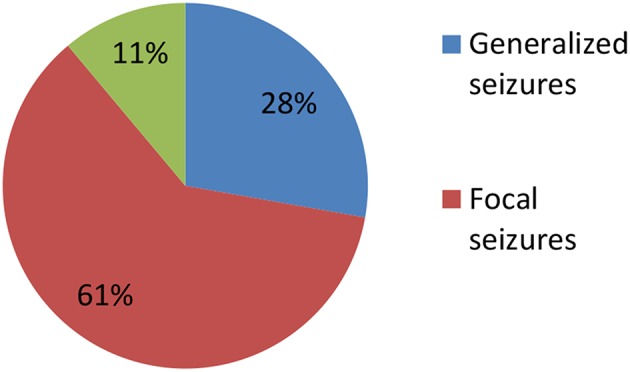
Percentage of patients with focal, generalized, and both focal and generalized seizures epilepticus (SE).